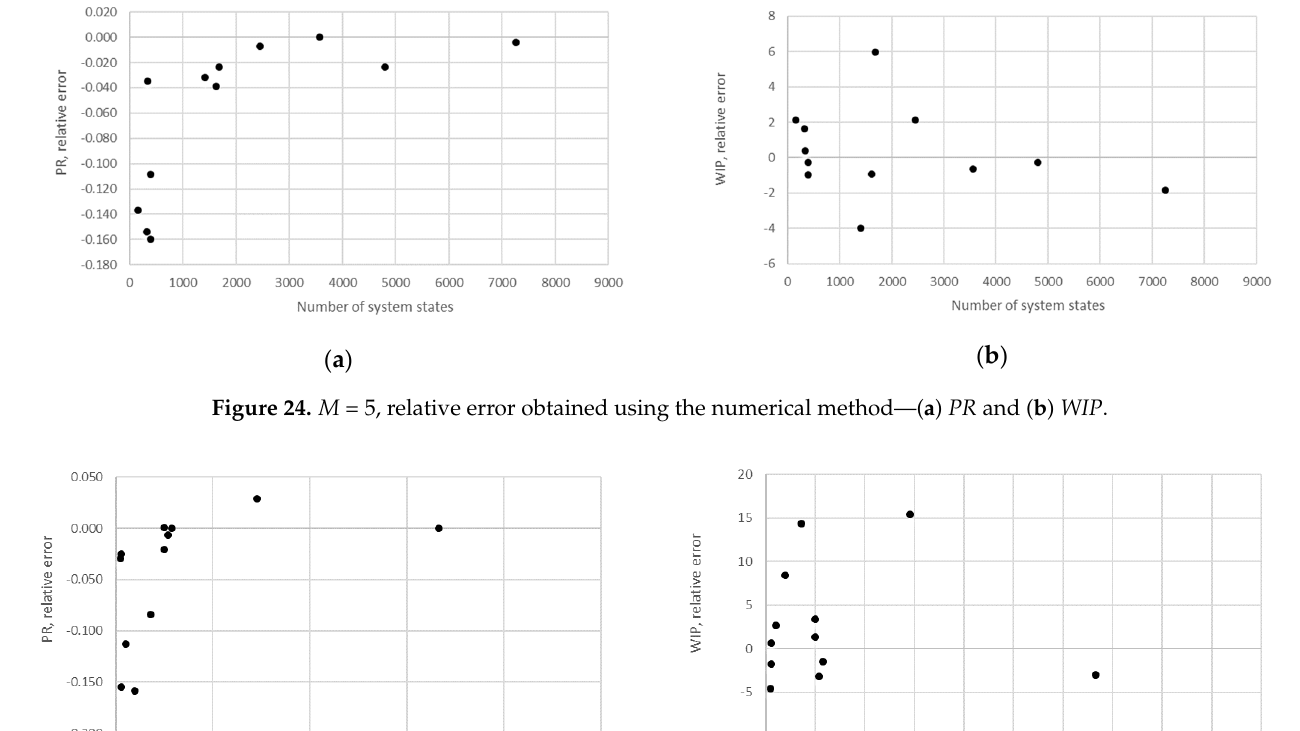
Figure 23. M = 4, relative error obtained using the numerical method—( a ) PR and ( b ) WIP.